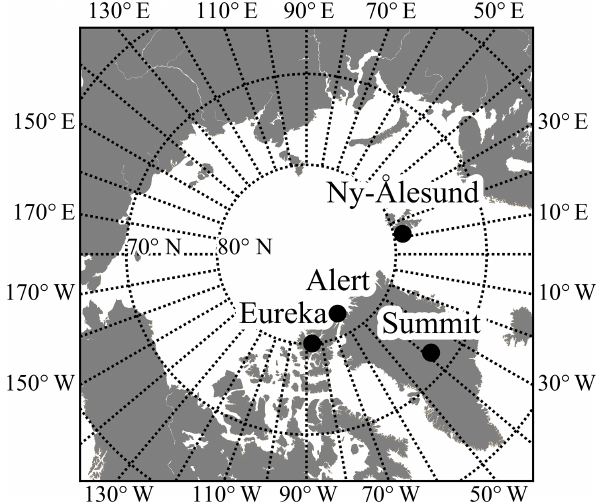
Figure 1. Map showing the locations of study sites used: Sum- mit Station, Greenland; Ny-Ålesund, Svalbard, Norway; Alert, Nunavut, Canada; and Eureka, Nunavut,